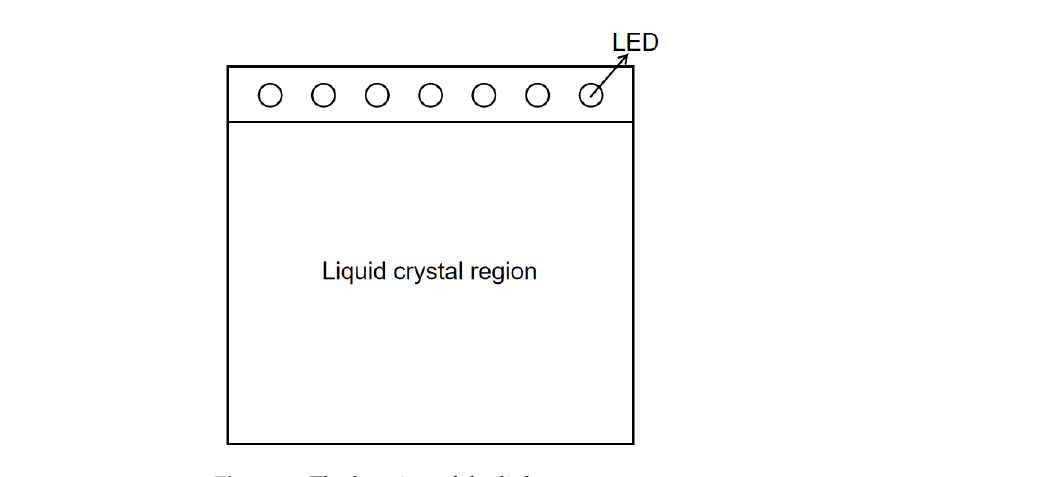
Figure 3. The location of the light source.